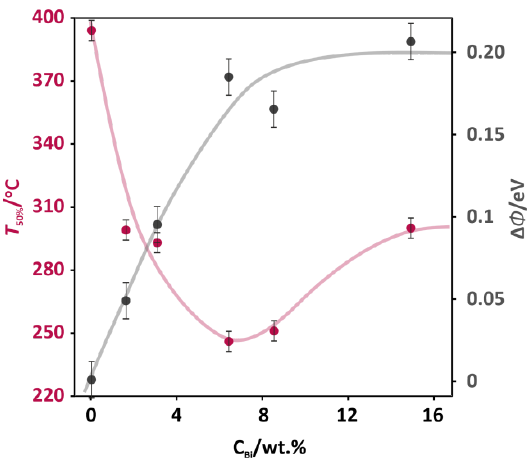
Figure 1. The catalytic activity expressed as the temperature of 50% N 2 O conversion ( T 50% ) and work function change ( ∆ Φ ) as a function of the Bi promoter concentration ( C Bi ) for the Co 3 O 4 -based catalysts.